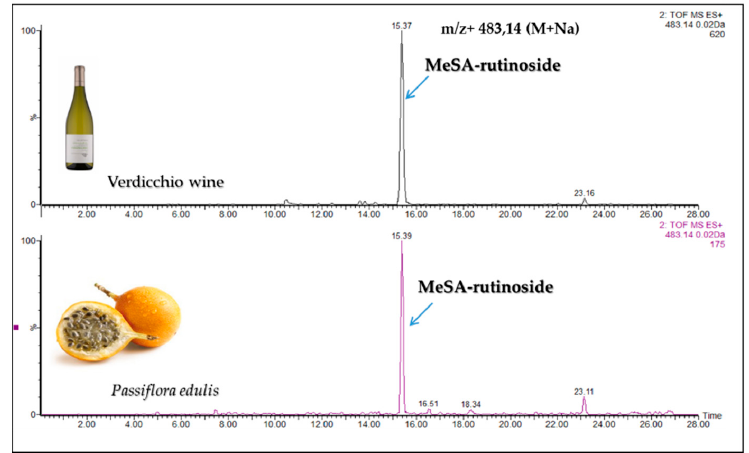
Figure 2. Extracted chromatogram of m / z 483.14 with rutinoside diglycoside found in Verdicchio wine.